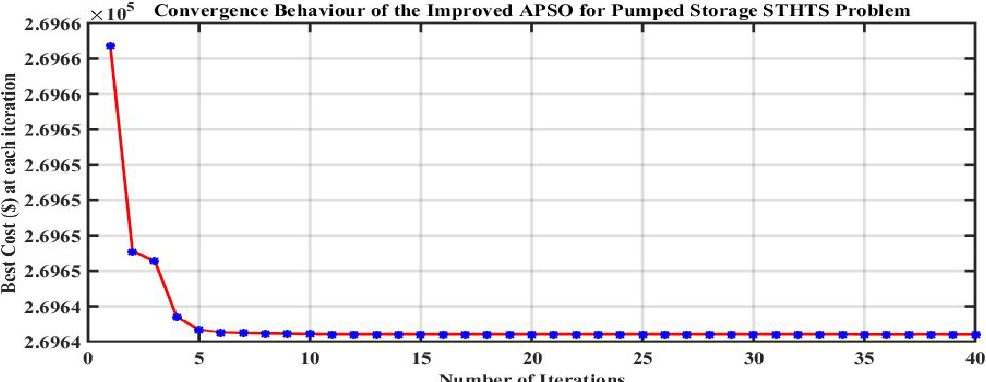
Figure 4. Convergence characteristics of the improved APSO algorithm on the non-cascaded pumped STHTS problem.